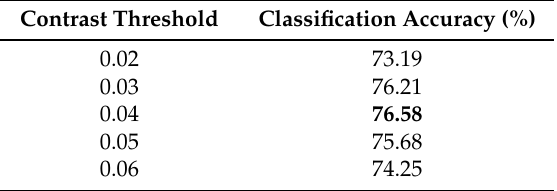
Table 3. Average classification accuracy of the SIFT over neuroblastic tumour dataset using different values for contrast threshold ( C C ). Bold value indicates the highest classification accuracy.